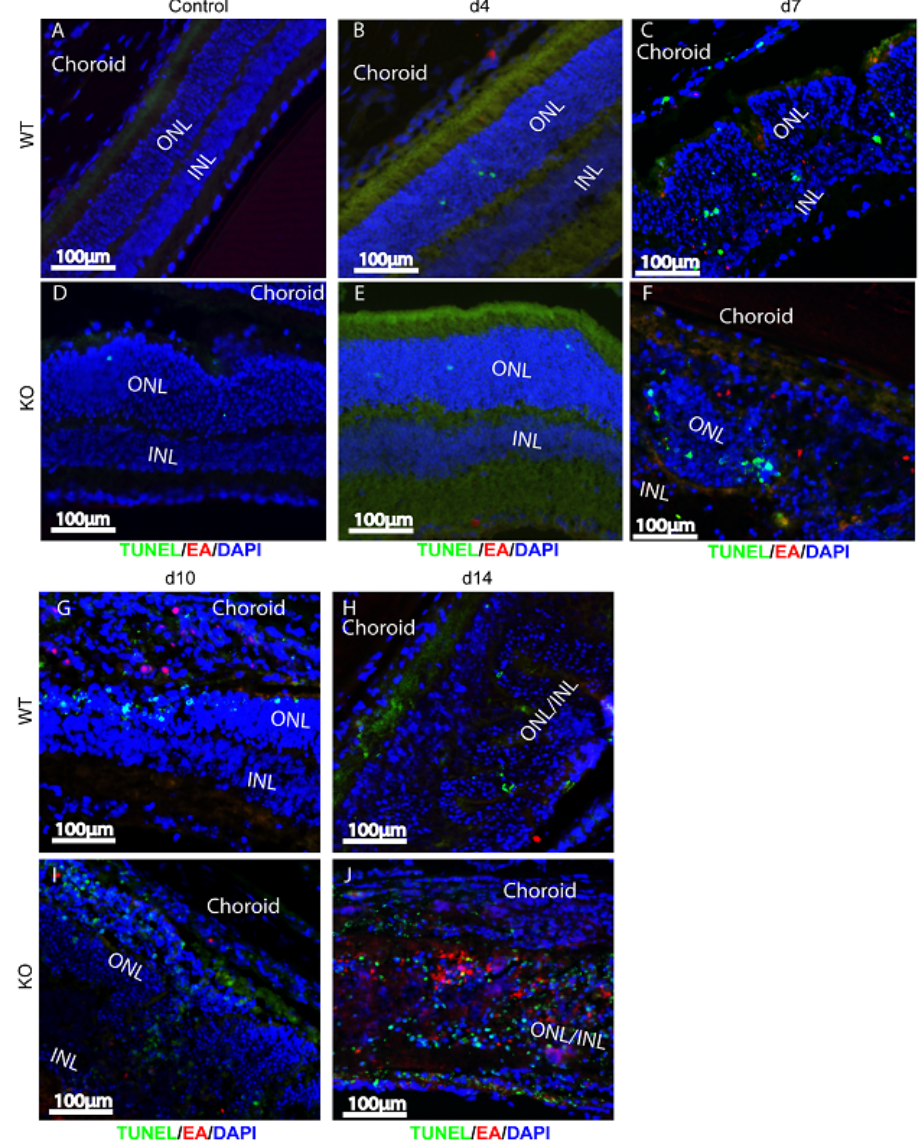
Figure 4. ( A – J ) Bystander retinal cell death. Representative merged photomicrographs of TUNEL staining (green), MCMV EA (red), and DAPI (blue) in MCMV-injected eyes or medium-injected controls of WT and caspase-12 − / − KO mice at day (d) 4, 7, 10, and 14 p.i. n ≥ 3. Since similar virus spread and replication were observed in both caspase-12 − / − and caspase-12 +/+ MCMV injected eyes at days 4, 7, and 10 p.i., eyes were harvested at these